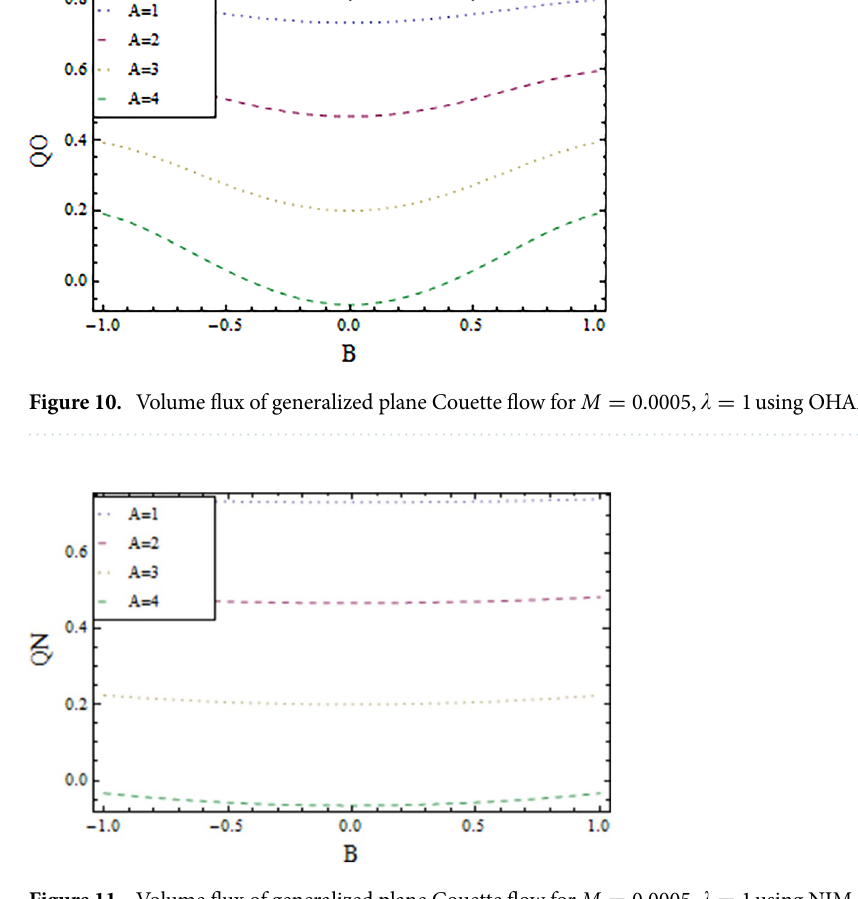
Figure 11. Volume flux of generalized plane Couette flow for M = 0.0005, (cid:31) = 1 using